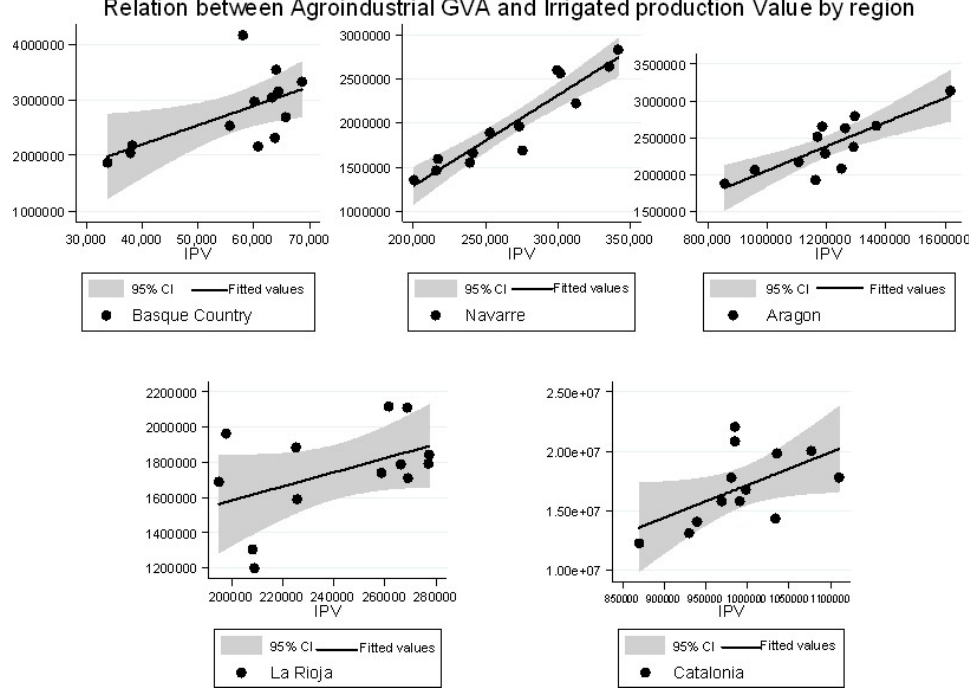
Fig. 3. Relation between observed irrigated production value (IPV, on x axis) and agri-food industrial output (GVA, on y axis). Source: authors’ elaboration, both axis are measured in 1000 C.